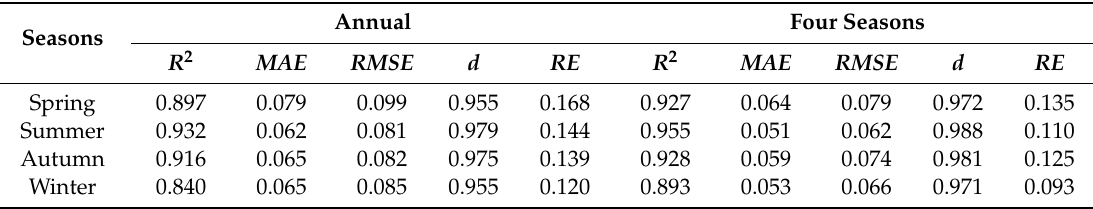
Table 3. Statistics for the estimation of relative sunshine duration at all 18 meteorological stations daily by season in 2016.